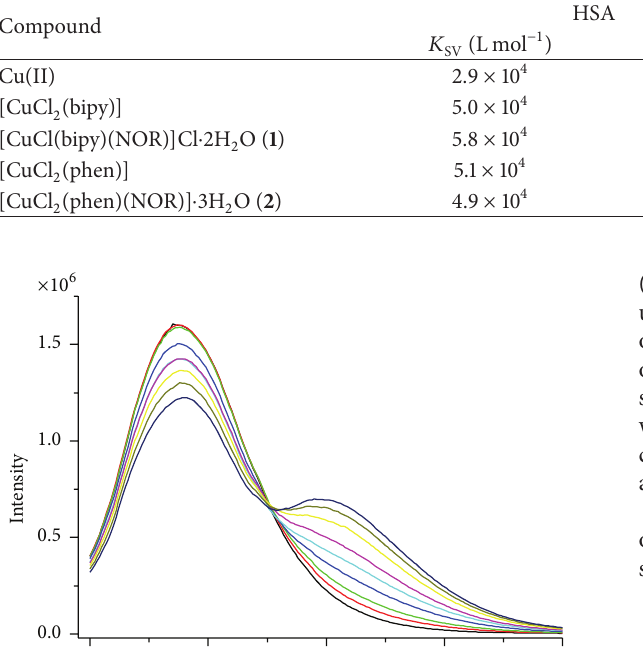
Table 3: Stern-Volmer constants values, 𝐾 10 4 Lmol −1 ).